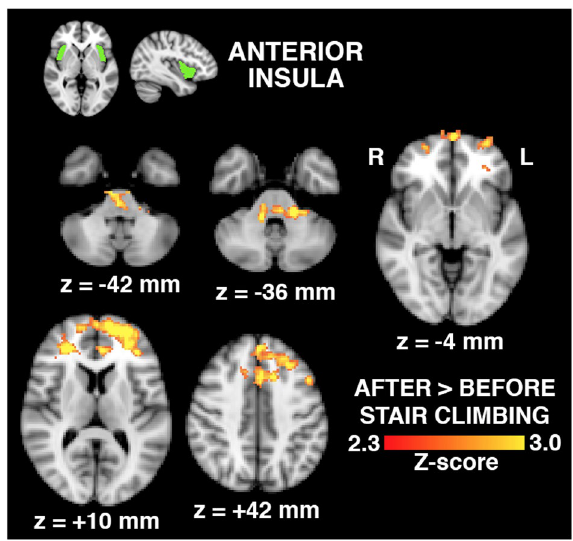
Figure 5. Brain regions (bottom, in red-to-yellow) exhibiting increased connectivity with the anterior insula seed region (top, in green) in hip OA patients (n = 30) following physical activity involving the hip, expressed as a statistical Z-score of the difference. Regions include the brainstem and regions within the left and right medial, superior and frontal gyri, as well as the anterior cingulate cortex (z-coordinates of shown brain slices correspond to the MNI brain